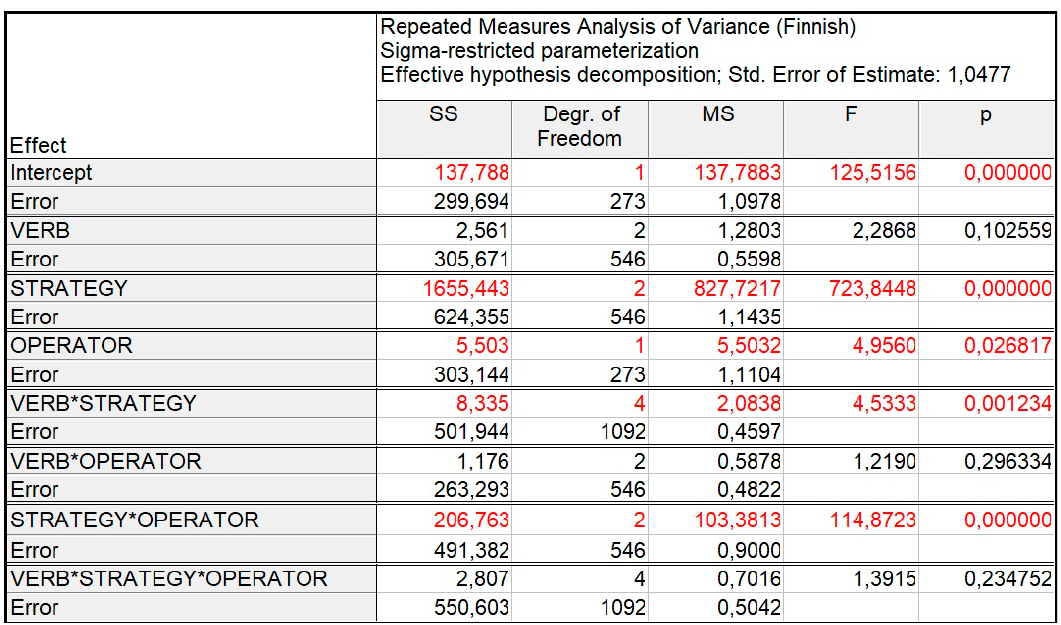
Figure 6. Verb*Strategy post hoc results (Finnish) . However, a significant difference arises between transitive and unergative verbs in the case of FF. Specifically, the acceptability of sentences featuring a fronted transitive object is significantly lower than sentences featuring a fronted unergative object (cf. Figure 6, cell no. 2 vs. 5). On the other hand, unaccusatives are located halfway between the other two verb types, since they do not show any significant difference with either of them ( p = 0.07 and 0.98 respectively).